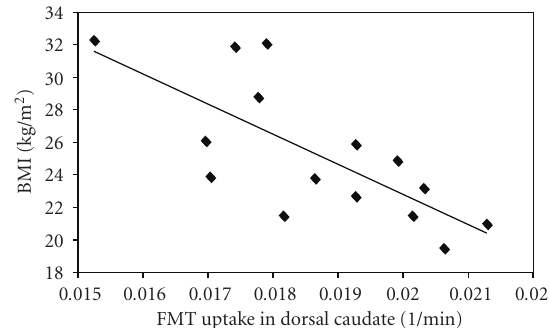
Figure 2: Relationship between body mass index (BMI, kg/m 2 ) and FMT uptake in the dorsal caudate averaged over left and right hemispheres in 15 young healthy individuals. FMT uptake reflects dopamine synthesis capacity and is measured as partial volume corrected influx constant, or K i in 1/min.